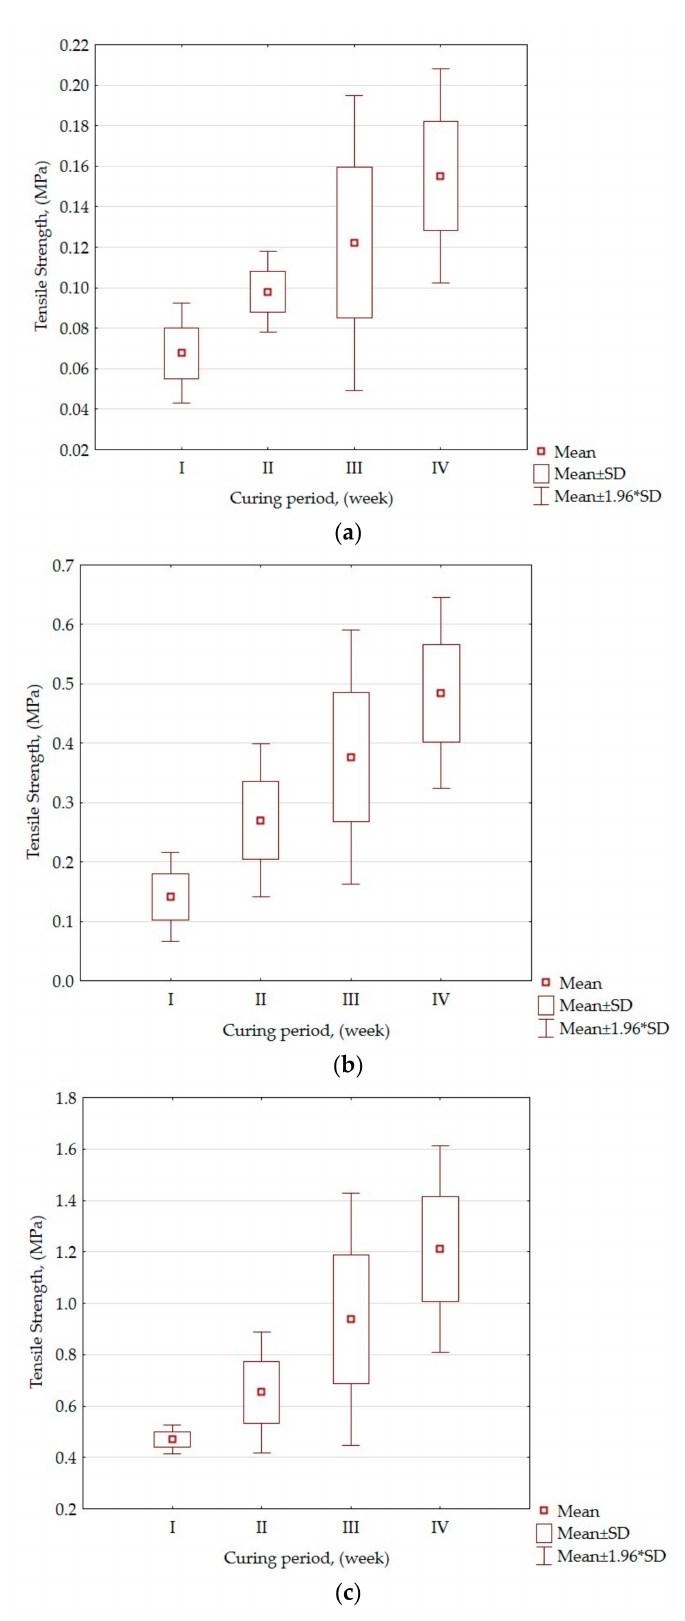
Figure 8. Tensile strength (Brazilian test) of the paste backfill in the period up to the fourth week with addition of: ( a ) 5% cement; ( b ) 10% cement; ( c ) 15% cement. SD—standard